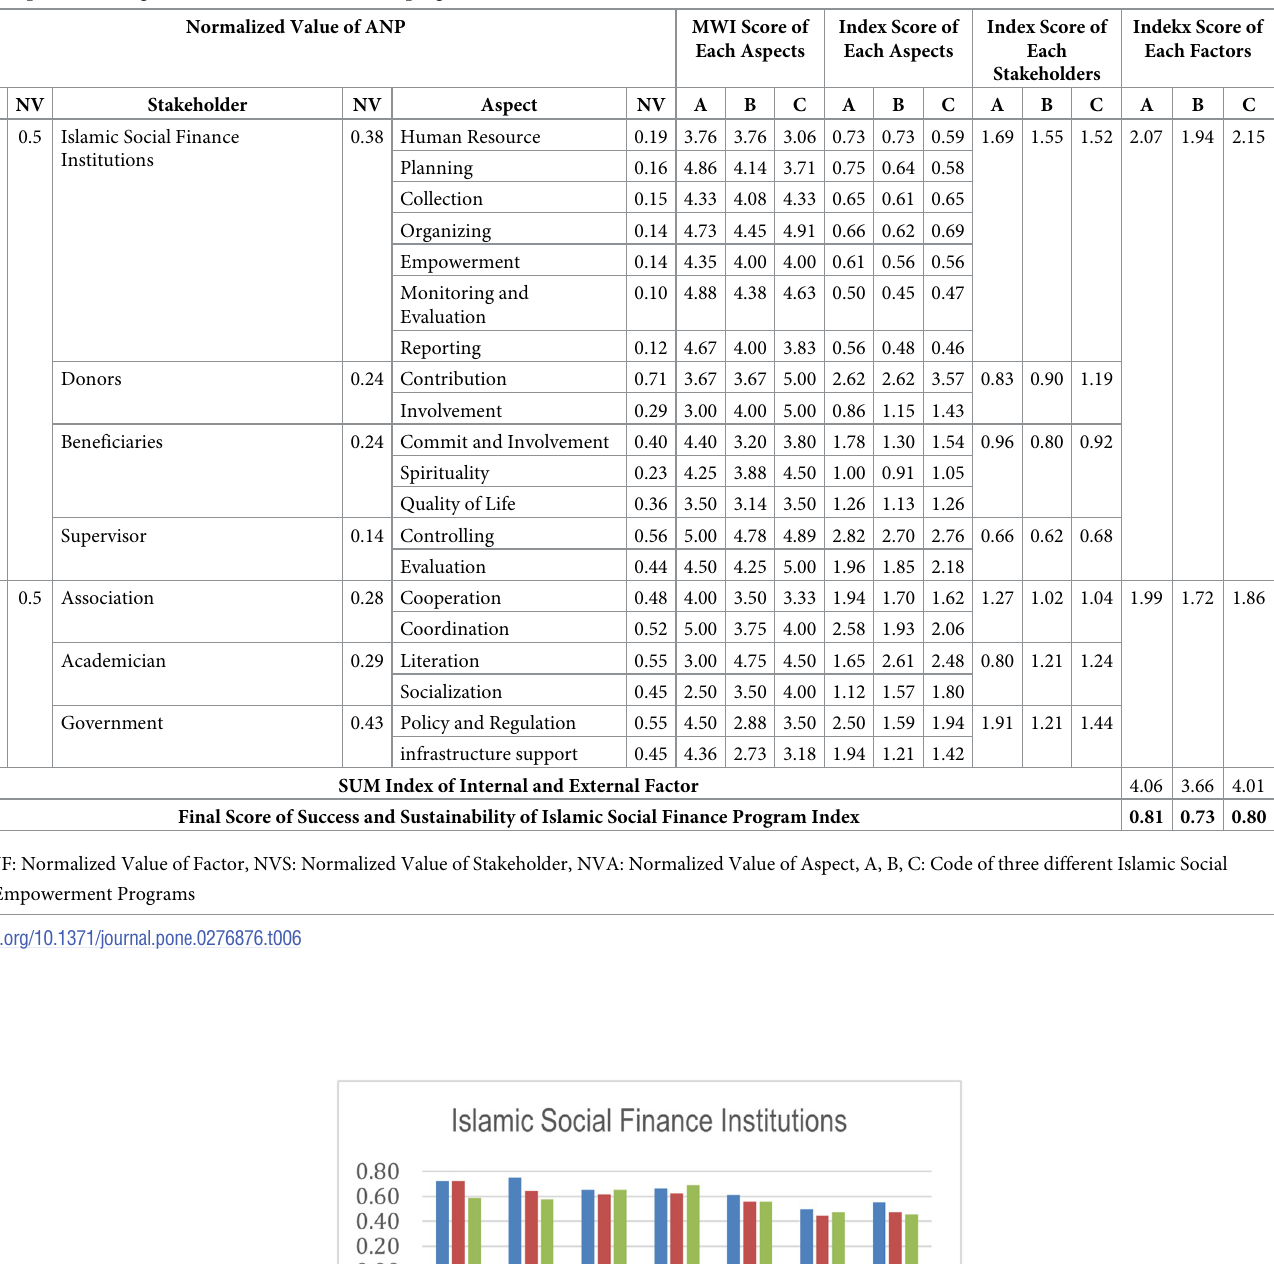
Table 6. Empirical investigation of Islamic Social Finance program.